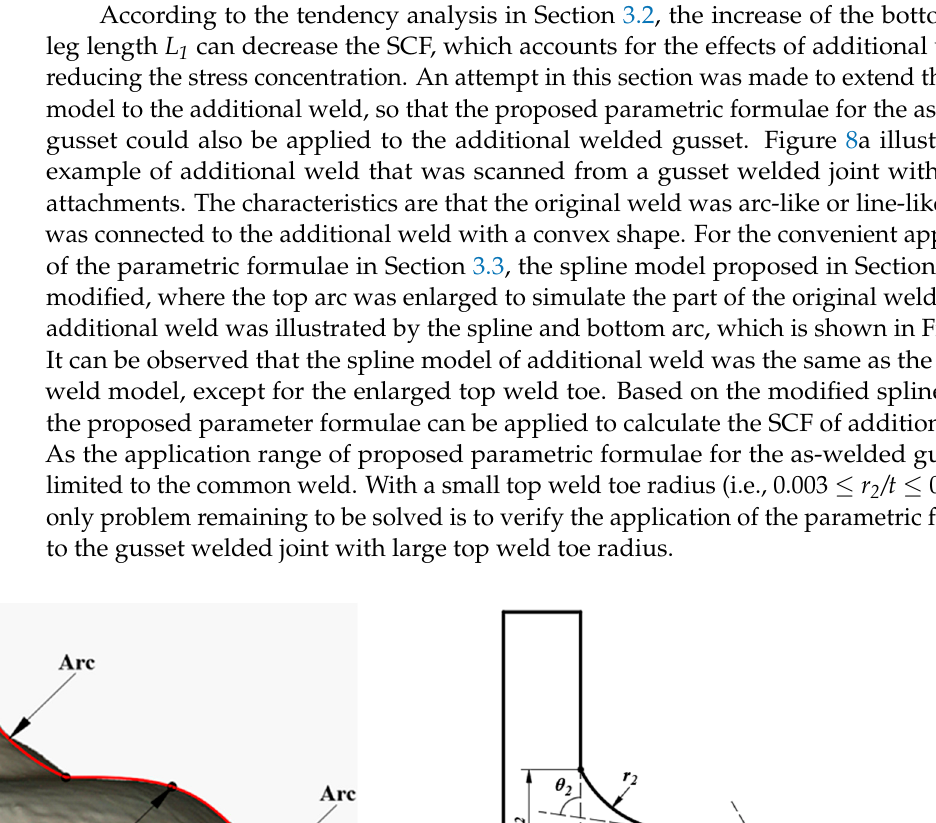
Table 1. The mechanical and chemical composition of the material.